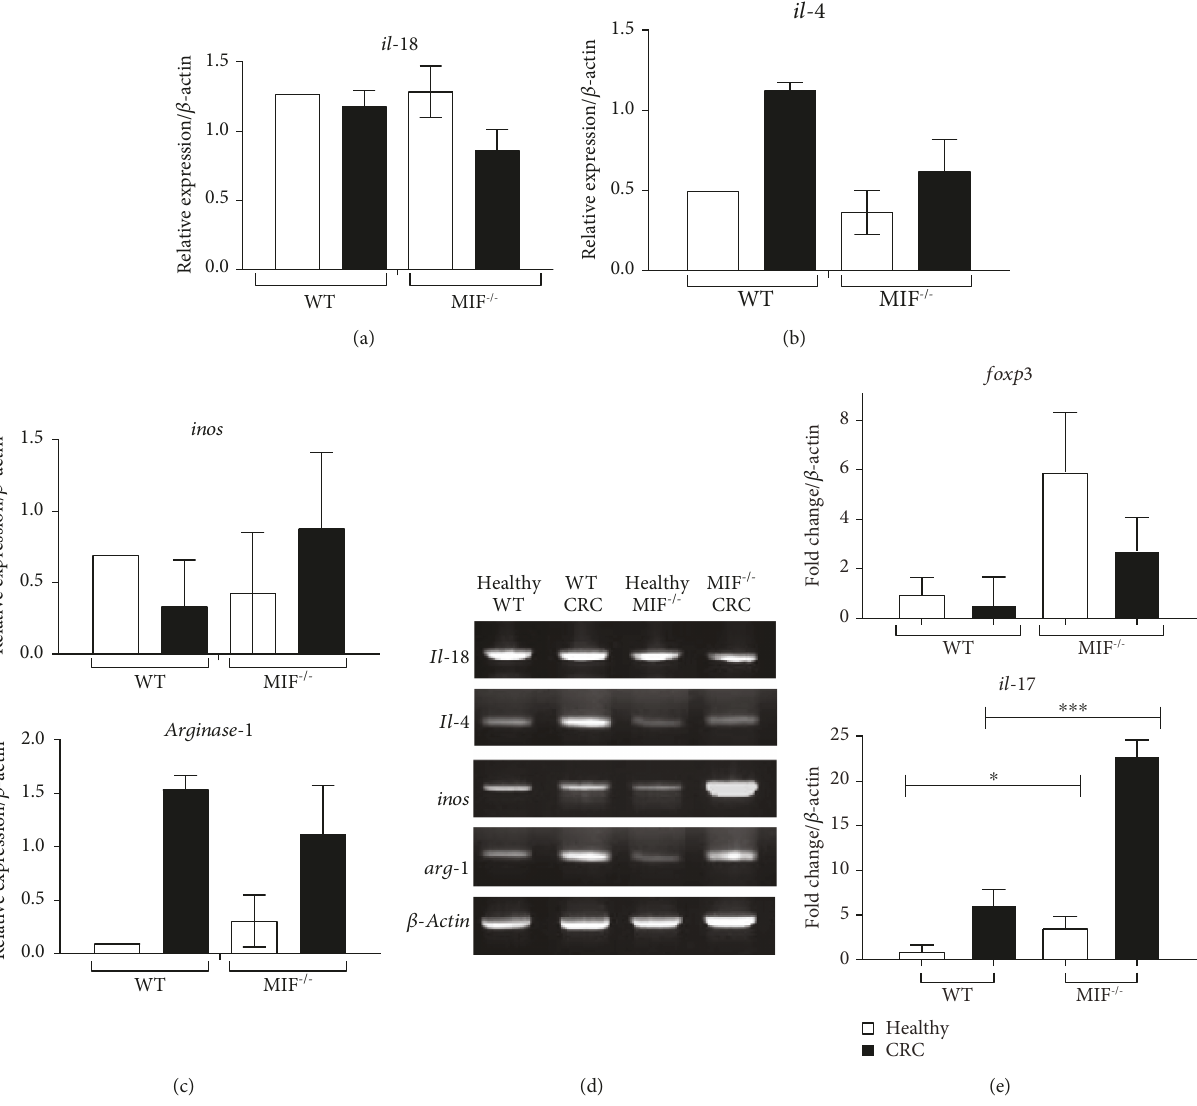
Figure 7: MIF de fi ciency promotes Th17 cytokine pro fi le development and the alternative activation of macrophages in the colon. Transcripts of molecules related to the tumor microenvironment pro fi le were analyzed by RT-PCR. In this fi gure, we show the expressions of (a) il-18 , (b) il-4 , and (c) inos and arginase-1 relative to the housekeeping gene β -actin . (d) Representative electrophoresis gels are shown to show di ff erences between groups. (e) Real-time PCR measurement of relative gene expressions of foxp3 and il-17 . Data are representative of two independent experiments and are plotted as the means ( ± SEM), n = 3 mice per group; ∗ p < 0 05 , ∗∗ p < 0 01 , and ∗∗∗ p < 0 001